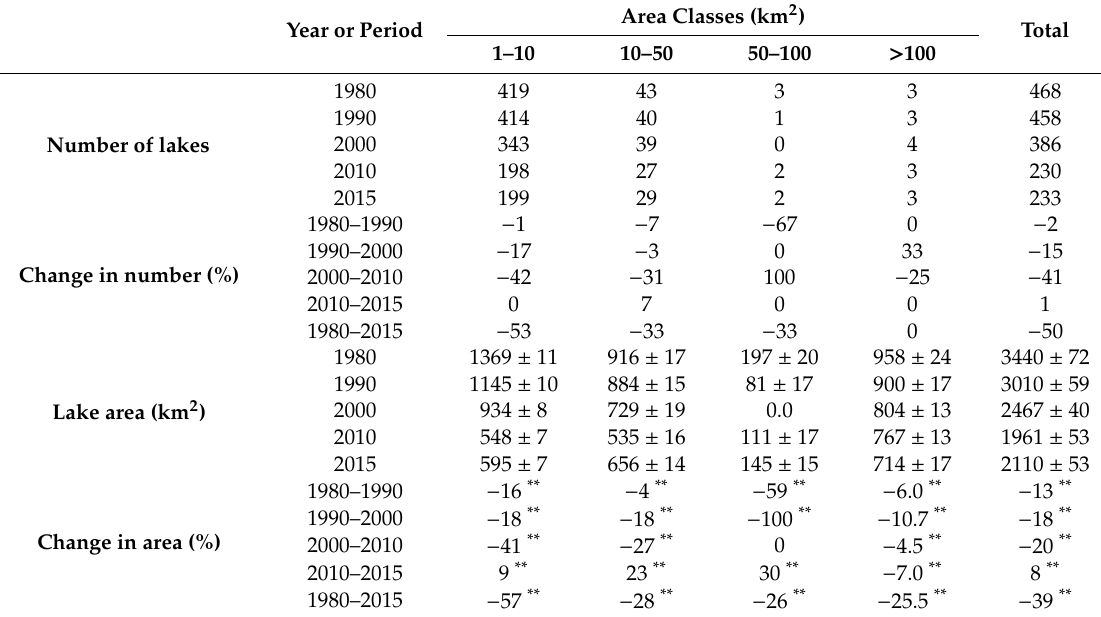
Table 3. Lake number, area, and changes in di ff erent classes between 1980 and 2015.